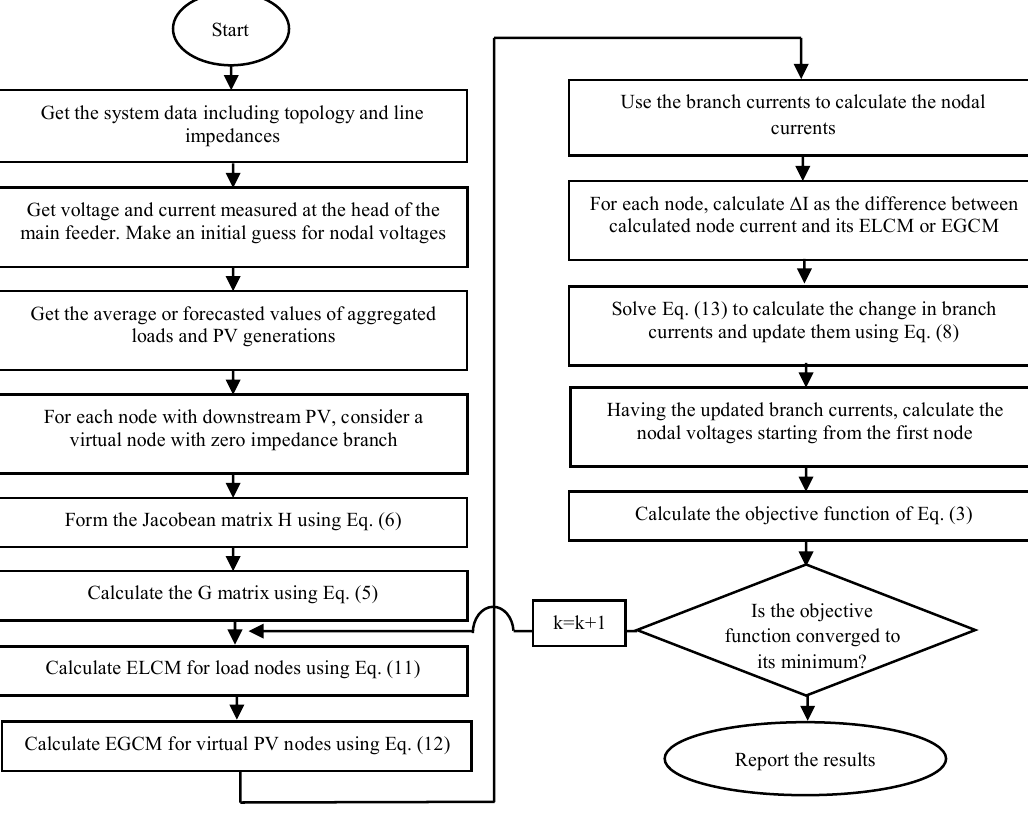
Fig. 3. Flowchart of the proposed BSE state estimation Figure 5. Flowchart of the proposed BSE state